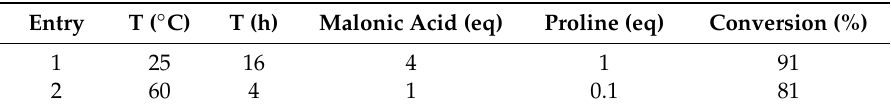
Table 2. Theorical optimal conditions for vanillin conversion into ferulic diacid according to the DoE software.